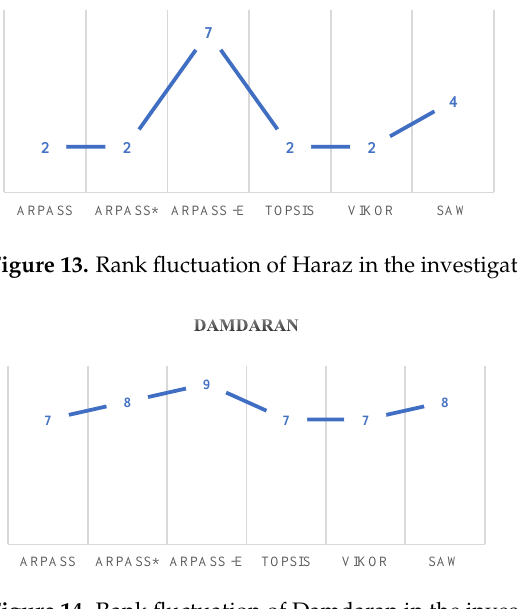
Figure 15. Rank fluctuation of Sabbah in the investigated MCDM methods. Figure 16. Rank fluctuation of Alima in the investigated MCDM methods. Figure 17. Rank fluctuation of Gela in the investigated MCDM methods.